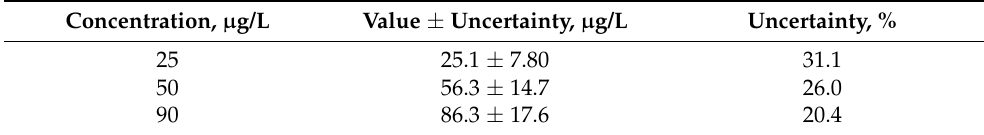
Table 9. Uncertainty values for electrochemical